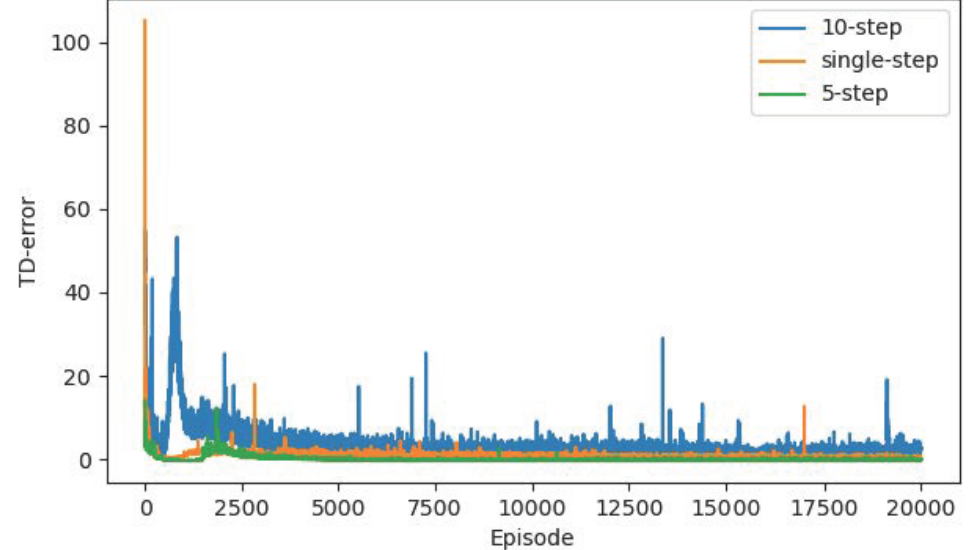
Figure 14. The TD-error curves of single-step, 10-step and 5-step mechanism based on R-SAC